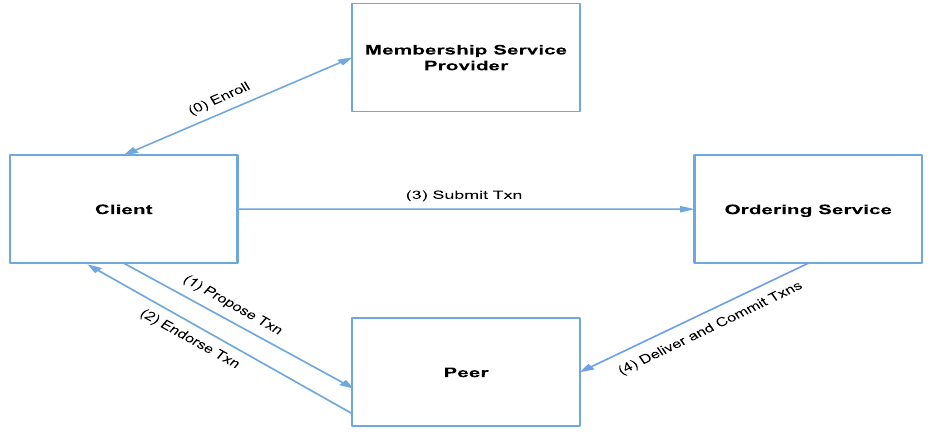
Figure 2. Main components of Hyperledger